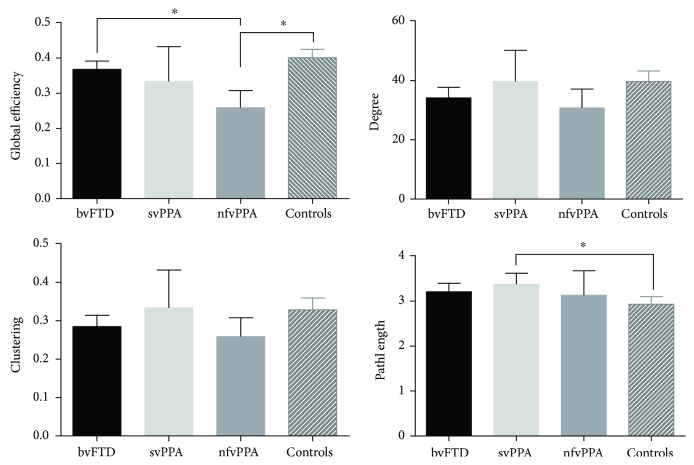
Mean bar of metrics from graph theory analysis by each group (global efficiency, degree, clustering, and path length). The bar represents the mean and error bars are a 95% confidence interval. ∗Significantly different with p < 0.05.